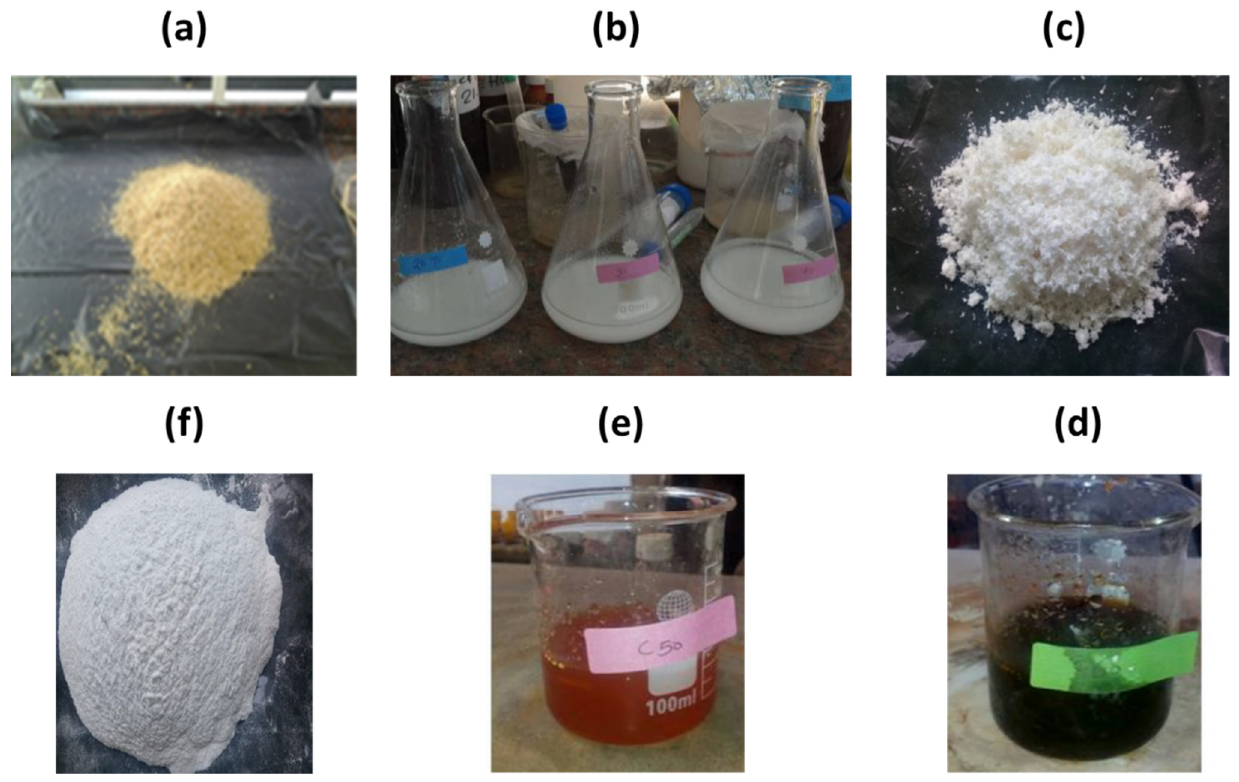
Figure 1. ( a ) Rice husk, ( b ) purification step, ( c ) purified RH, ( d ) RHA after the carbonization process, ( e ) formation of sol–gel, ( f ) final SiO 2 NPs product.